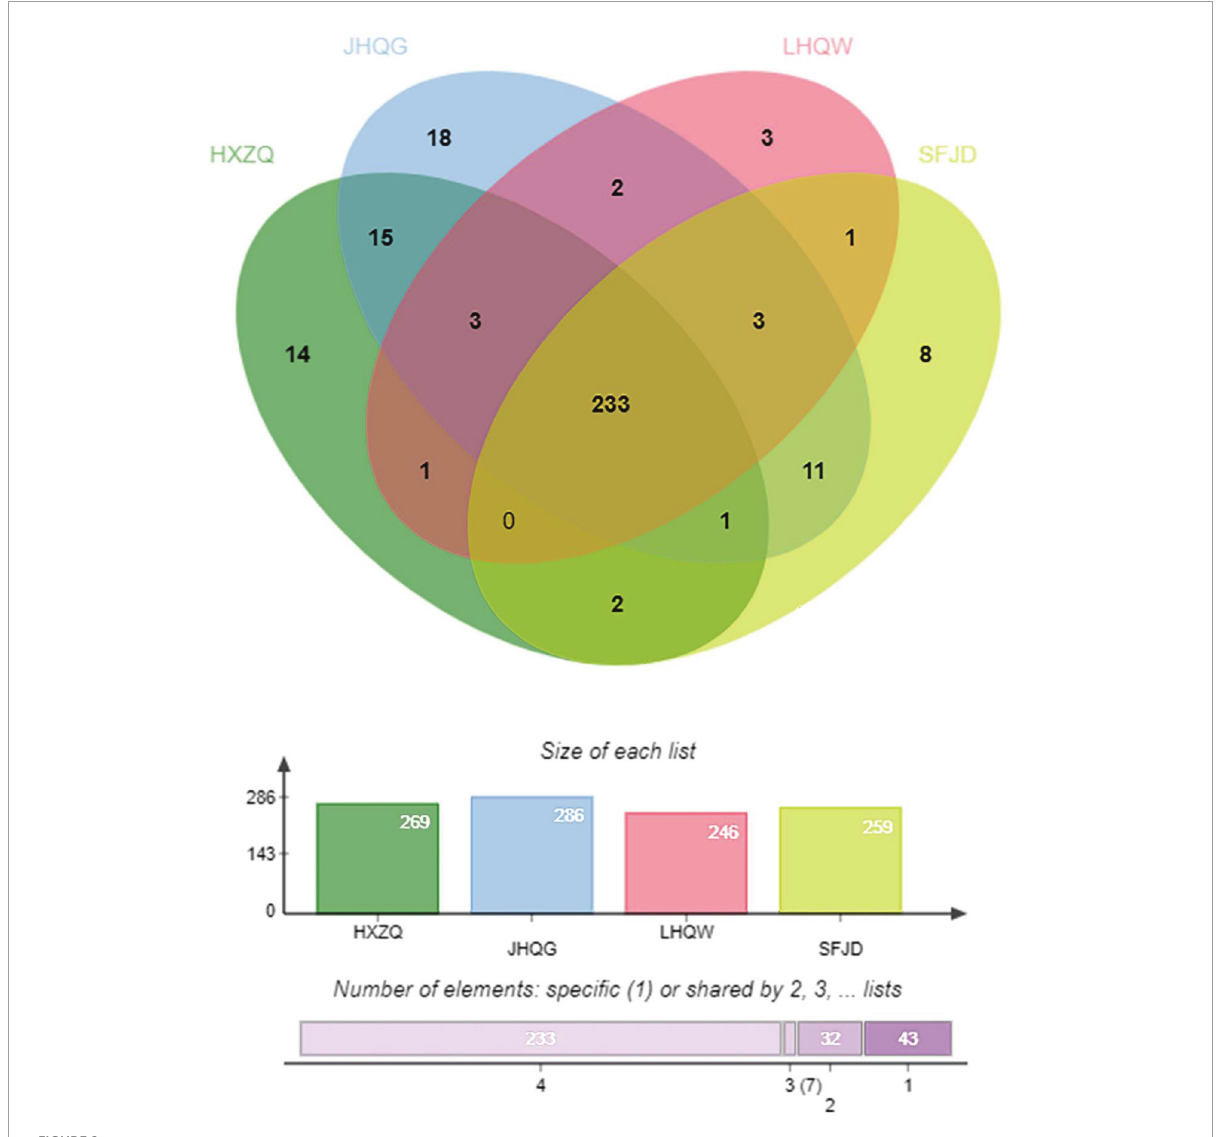
FIGURE2 Common targets of the four